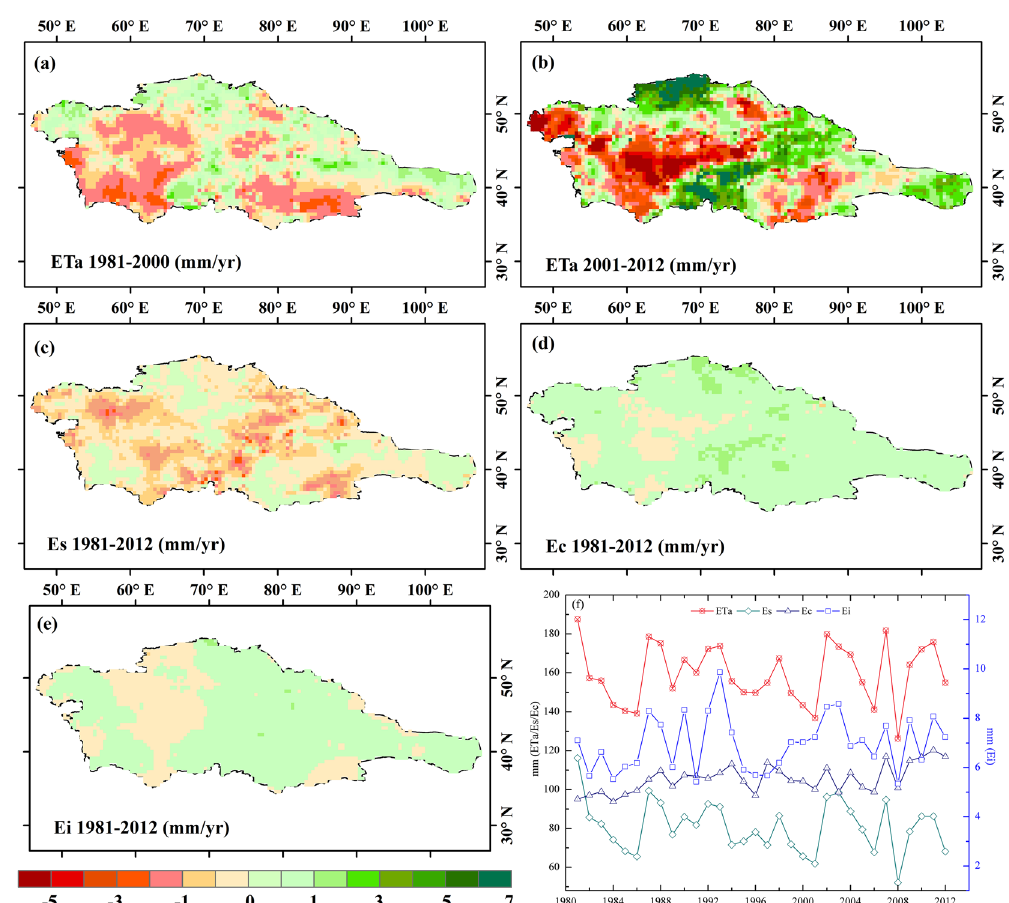
Figure 6. Trend differences of ET a and its components. ( a ) ET a in 1981–2000; ( b ) ET a in 2001–2012; ( c ) E s in 1981–2012; ( d ) E c in 1981–2012; ( e ) E i in 1981–2012; ( f ) time series of ET a , E s , E c and E i . (Generated by ArcGIS 10.2, URL: http://www.esri.com/software/arcgis/arcgis-for-desktop, and Matlab 2012a, URL: http://